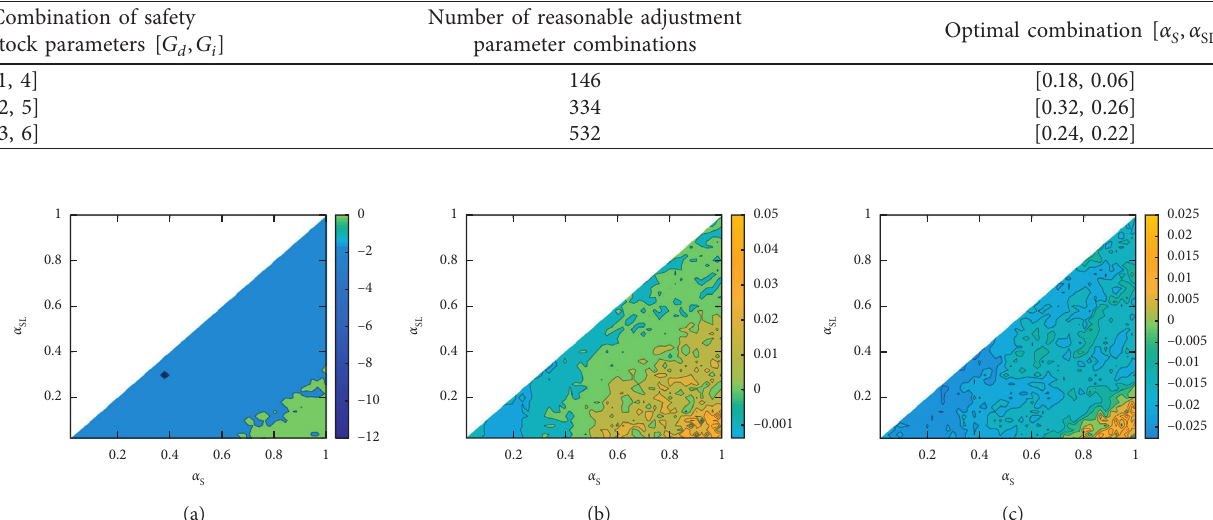
Table 3: The number and optimal combination of reasonable adjustment parameter combinations under the scenario of random demand obeying uniform distribution from the global perspective.